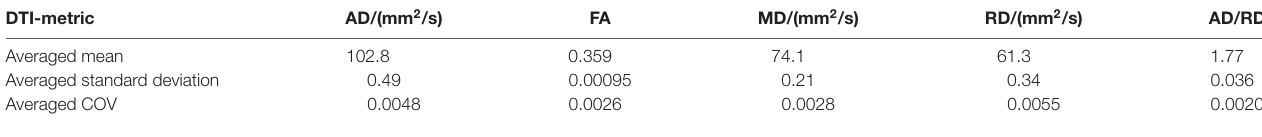
TABLE 2 | Arithmetically averaged standard deviation and coefficient of variation (COV) as a reproducibility measure of controls’ DTI metrics axial diffusivity (AD), fractional anisotropy (FA), mean diffusivity (MD), radial diffusivity (RD), and AD/RD.